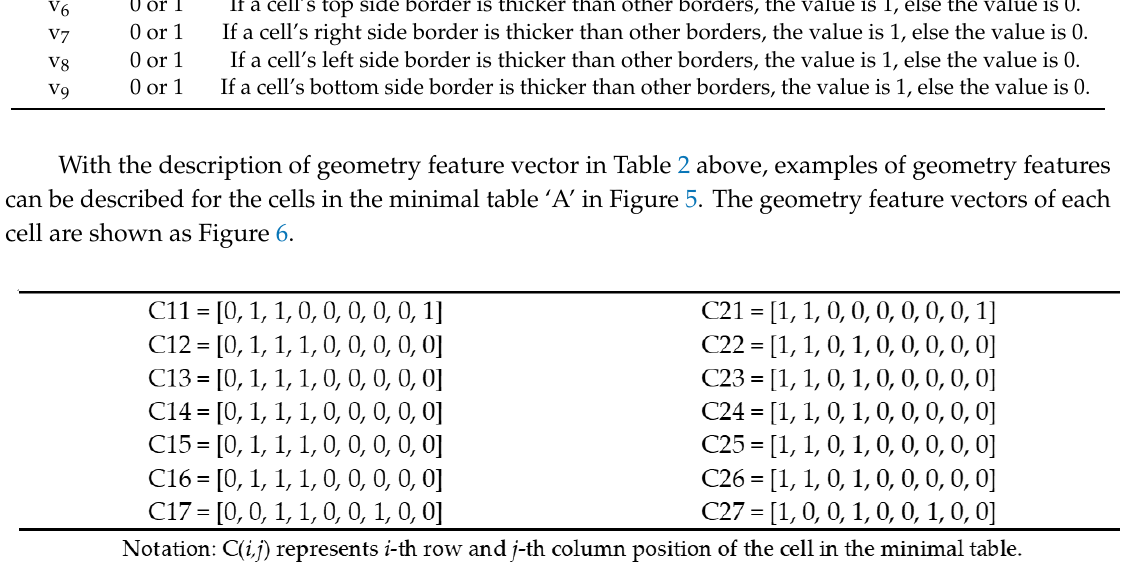
Figure 6. An example of geometry feature vectors.